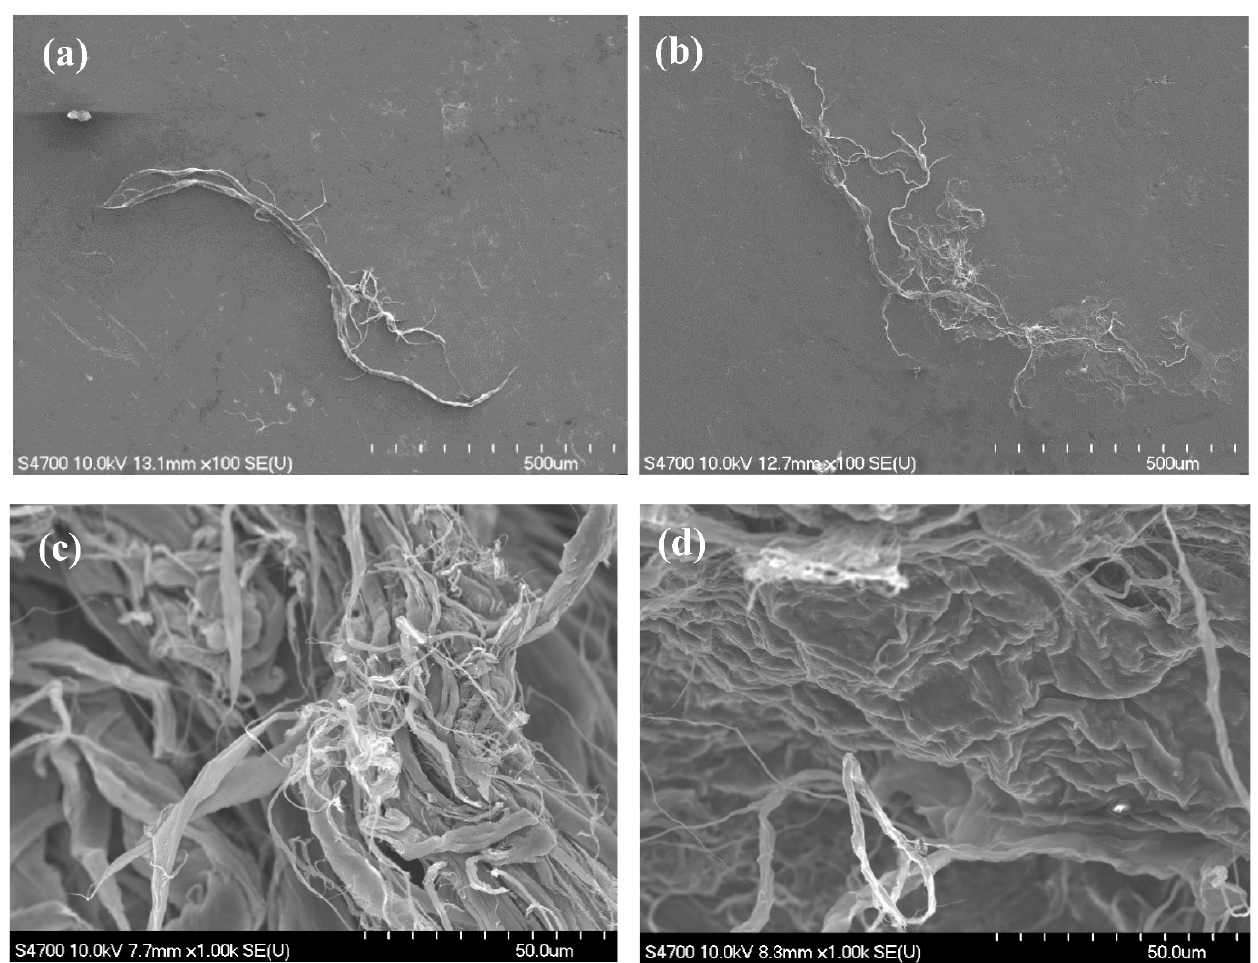
Figure 2. ( a ) FE-SEM image × 100 magnification for isolated bundle of as-received MIRALON® pulp; ( b ) FE-SEM image × 100 magnification for isolated bundle of MIRALON® pulp acid treated for 6 h in 10 M nitric at 120 °C; ( c ) FE-SEM image × 1000 magnification of entangled network for as-received MIRALON® pulp; ( d ) FE-SEM image × 1000 magnification of entangled network for MIRALON® pulp acid treated for 6 h in 10 M nitric at 120 °C.